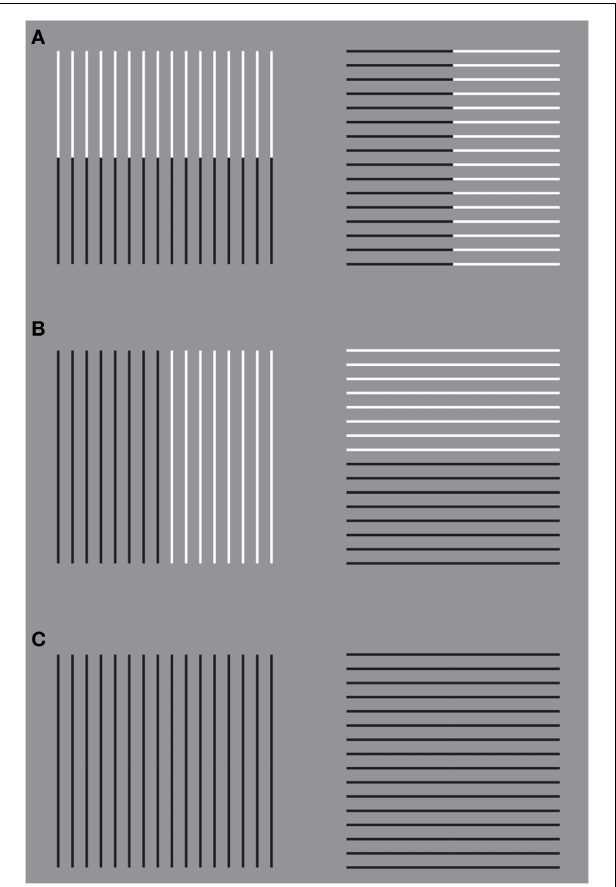
FIGURE 14 | The size effect of Helmholtz’s squares can be strengthened (A) or weakened (B) in relation to the control (C) by introducing new sources of directional